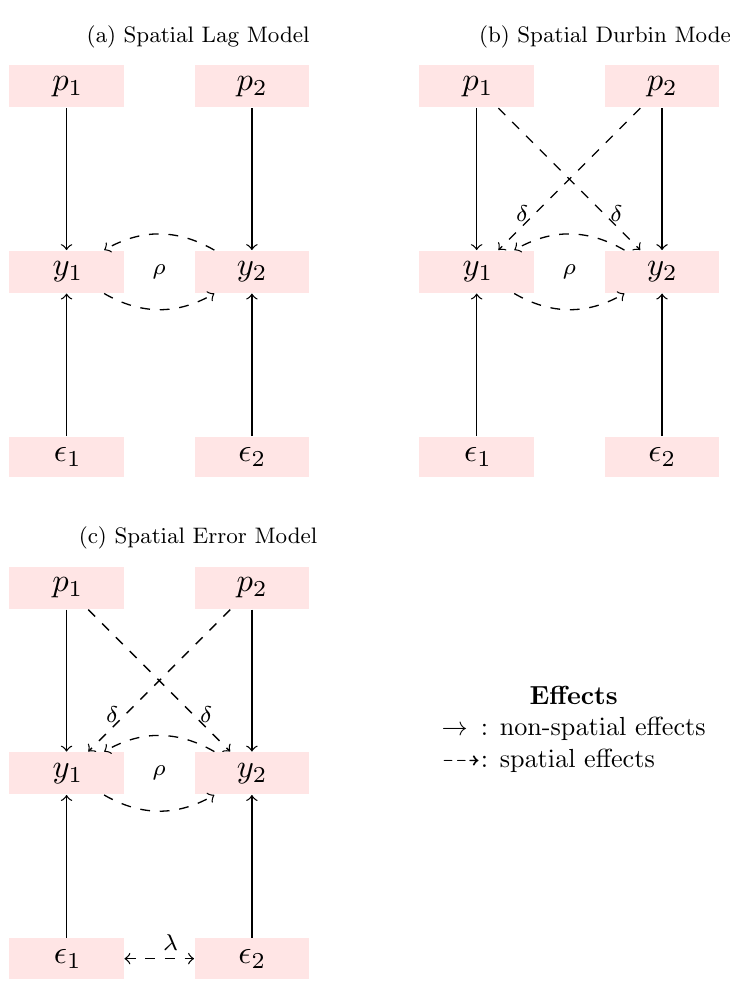
Figure 1: Spatial Econometric